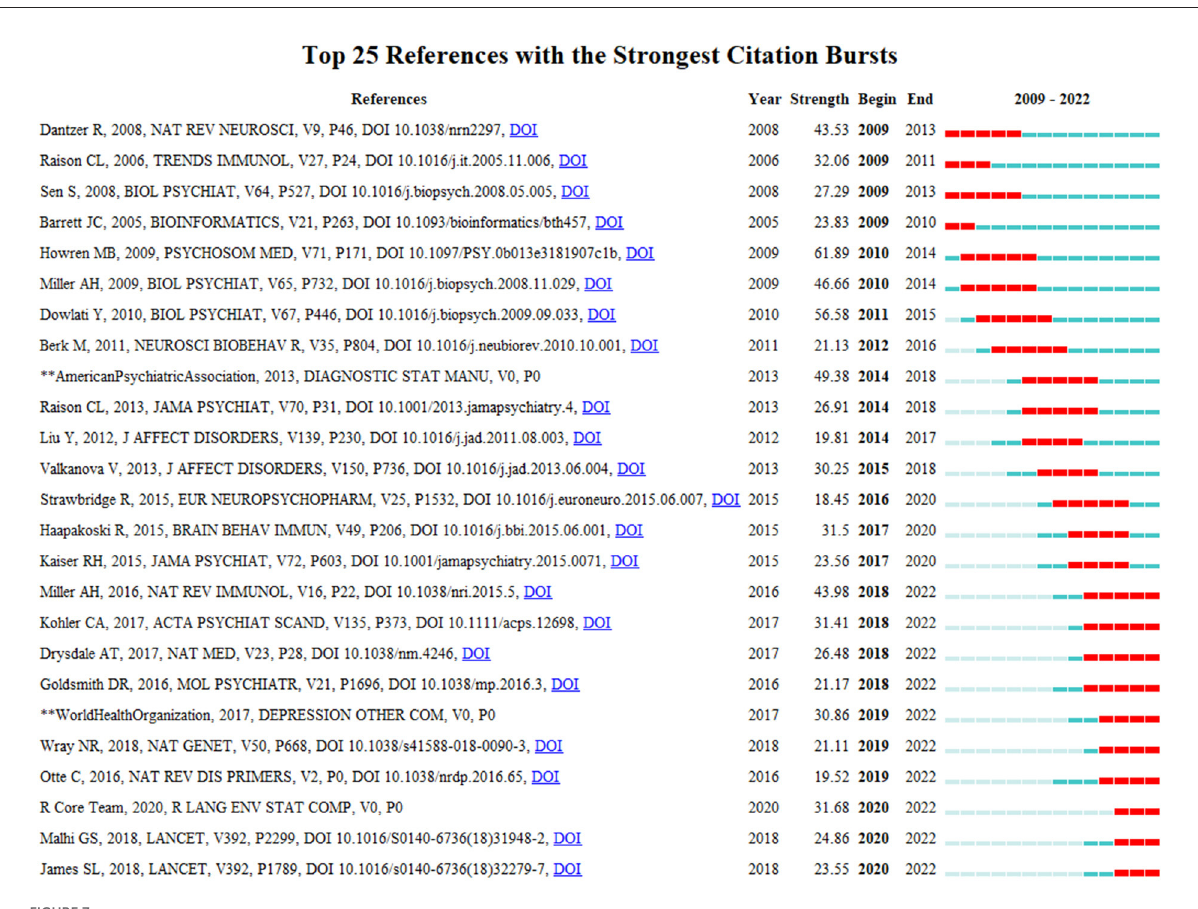
FIGURE7 Top 25 citings with the strongest citation bursts,